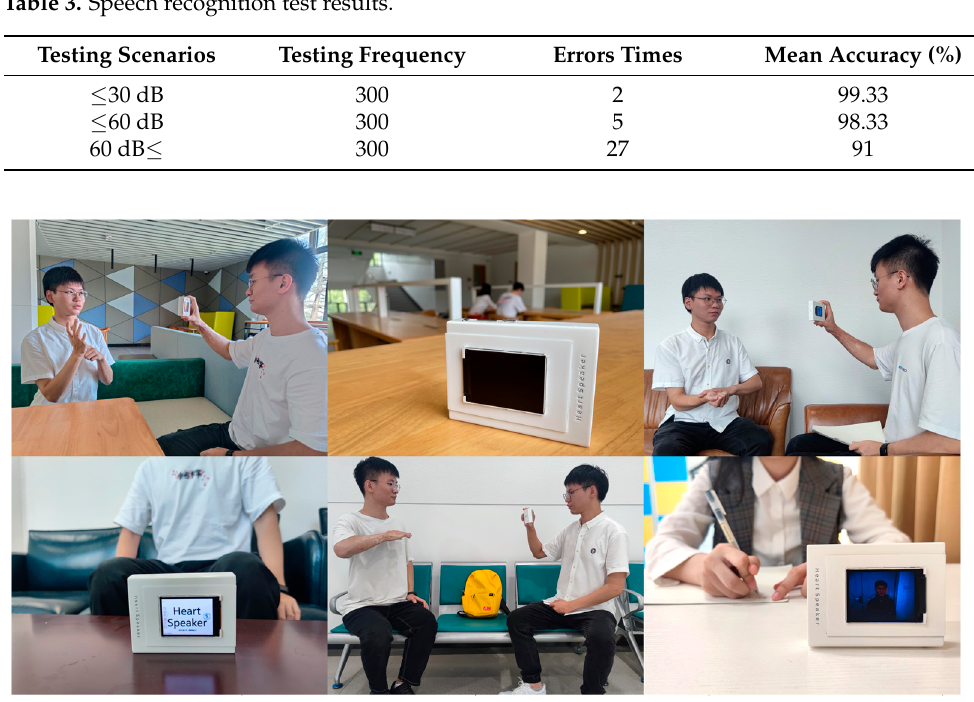
Figure 11. Serial port information successfully sent by the intelligent voice module.